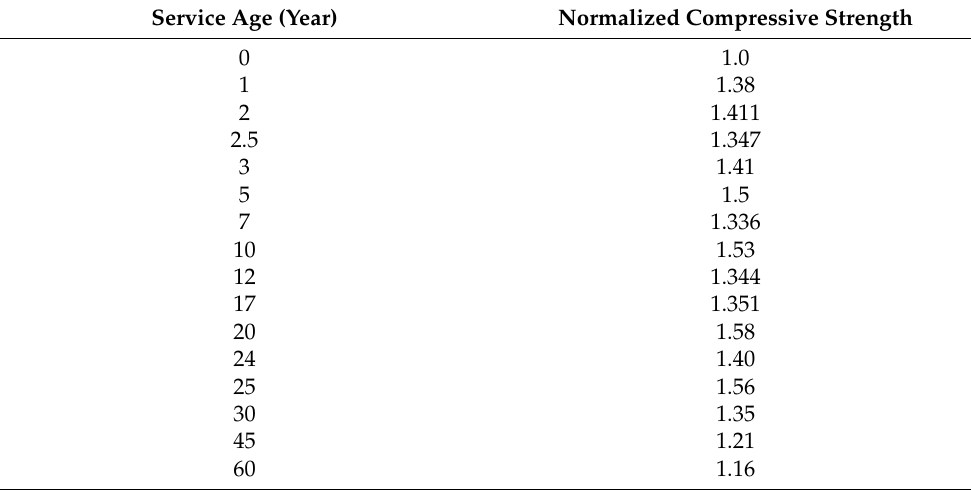
Table 2. Normalized compressive strengths collected by Niu.